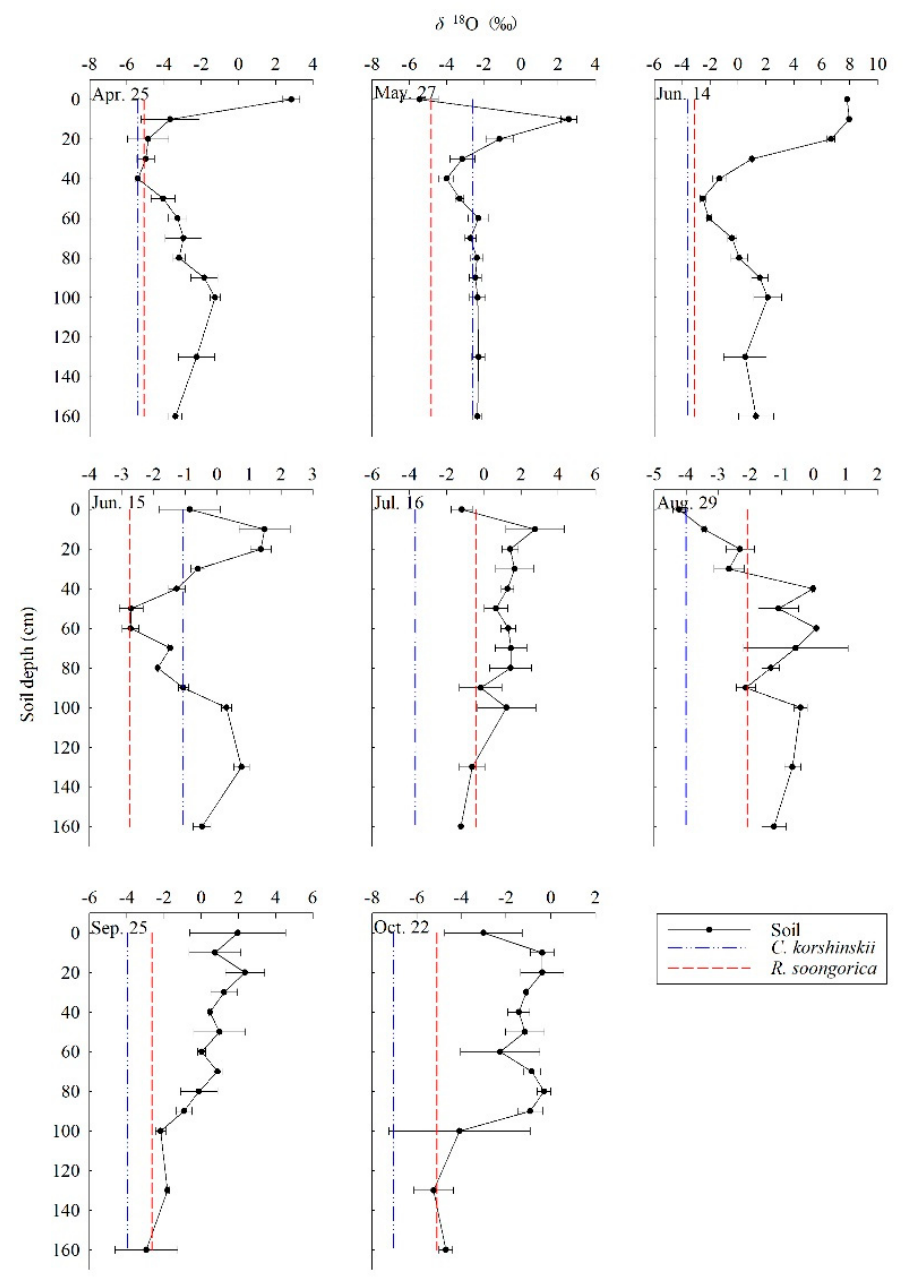
Figure 5. Seasonal variations of δ 18 O in soil horizons and xylem water from C. korshinskii and R. soongorica . (Mean ±S.D., N = 2).